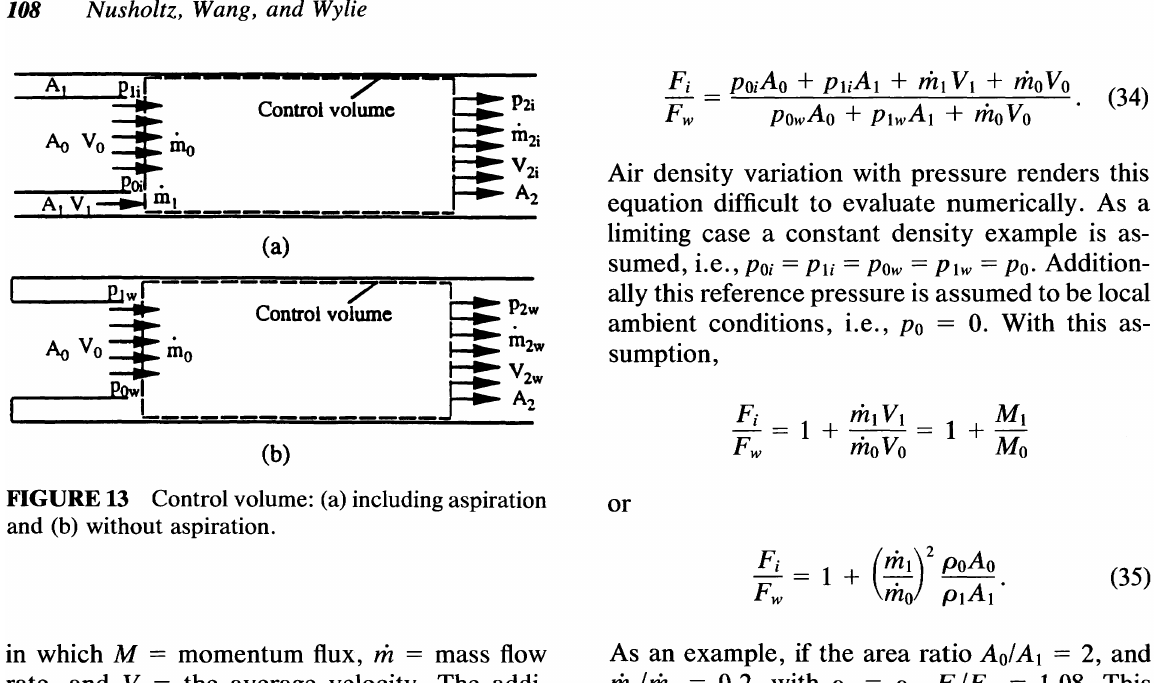
FIGURE 13 Control volume: (a) including aspiration and (b) without